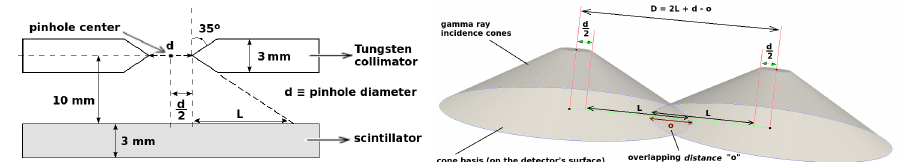
Figure 1. Schematic representation of the detector configuration formed by the scintillator and pinhole collimator together with different parameters used in this analysis, such as the pinhole diameter d , the length L , the distance between the detector and scintillator and their corresponding thickness, the distance D between two adjacent pinholes and the overlapping distance o .